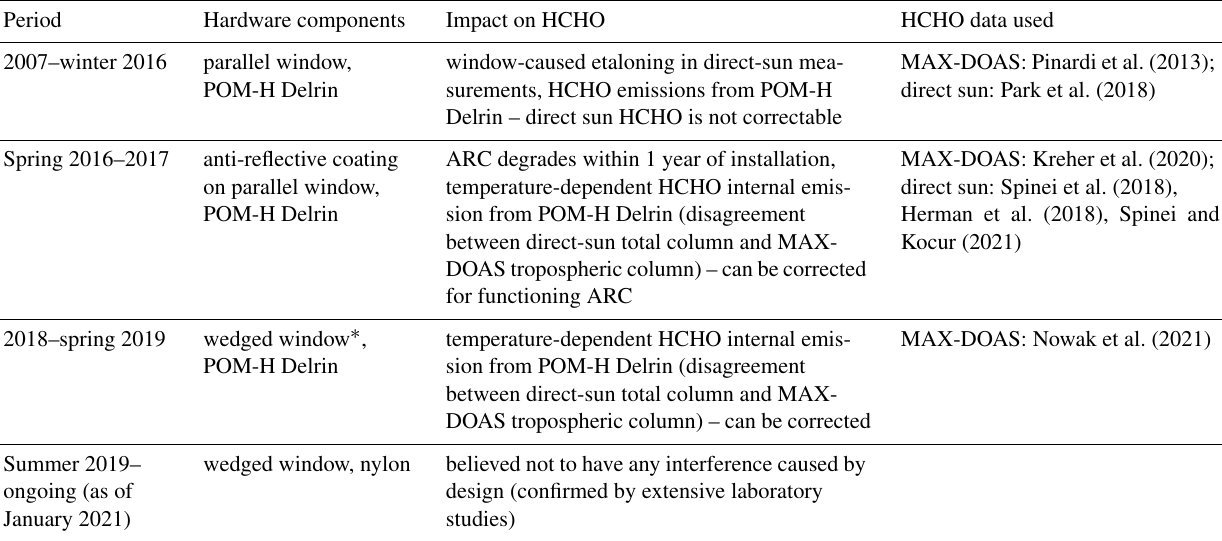
Table 2. History of Pandora hardware changes related to direct-sun HCHO measurements.